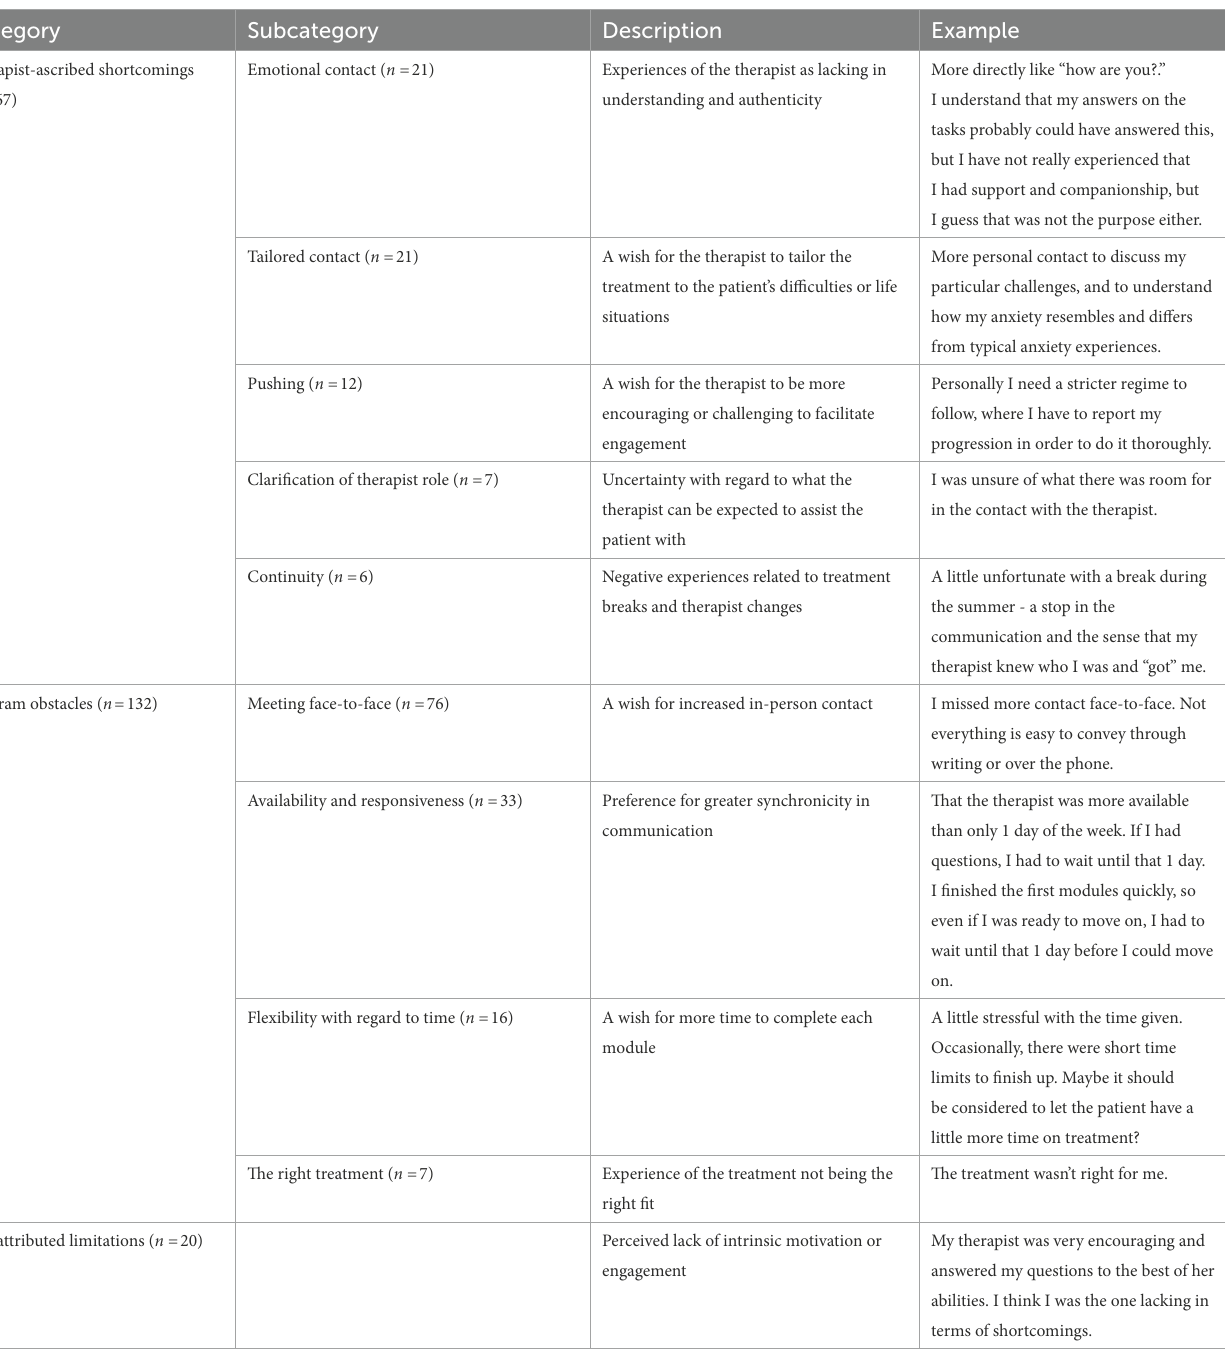
TABLE 2 Overview of qualitative categories and subcategories with